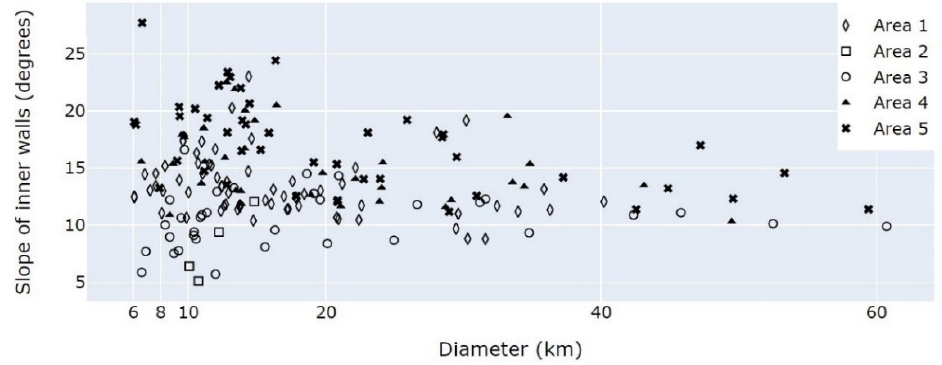
Figure 11. Slope of inner walls (Sw) versus diameter of impact craters. All craters plotted.